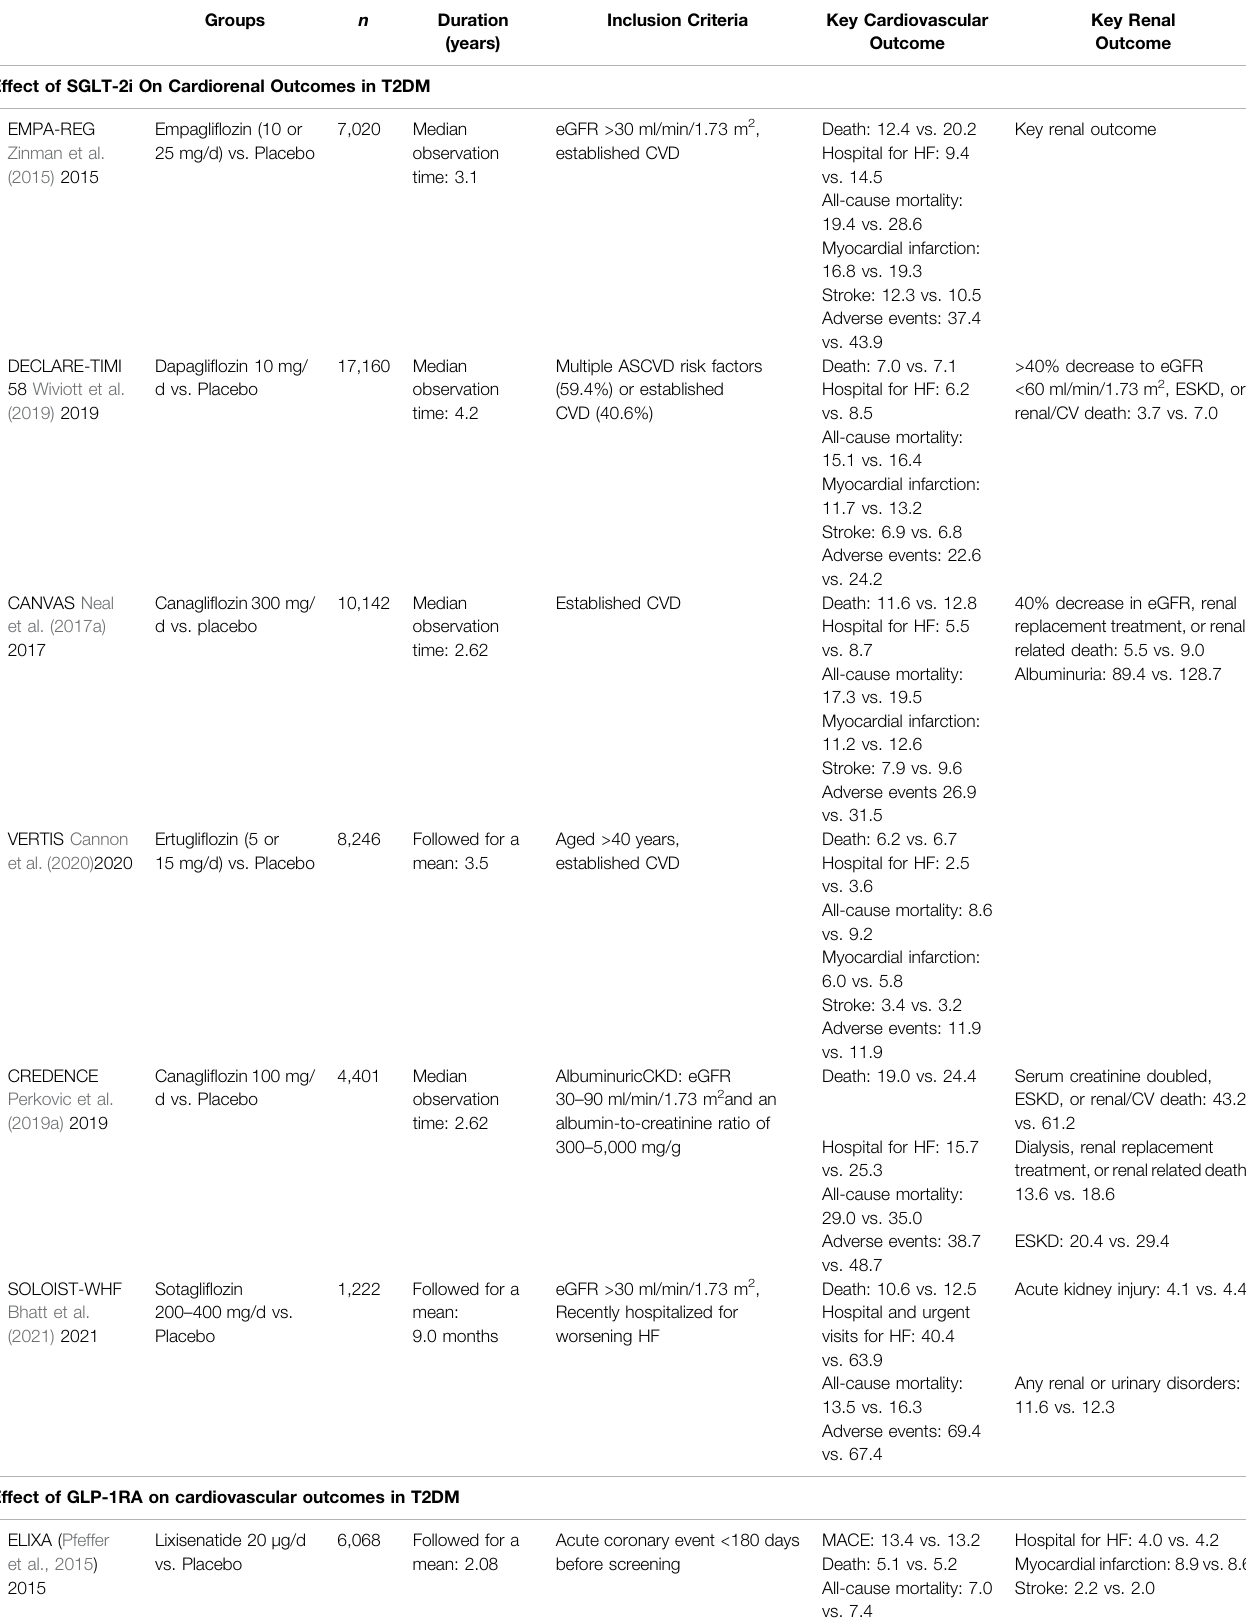
Inclusion Criteria Key Cardiovascular (years)